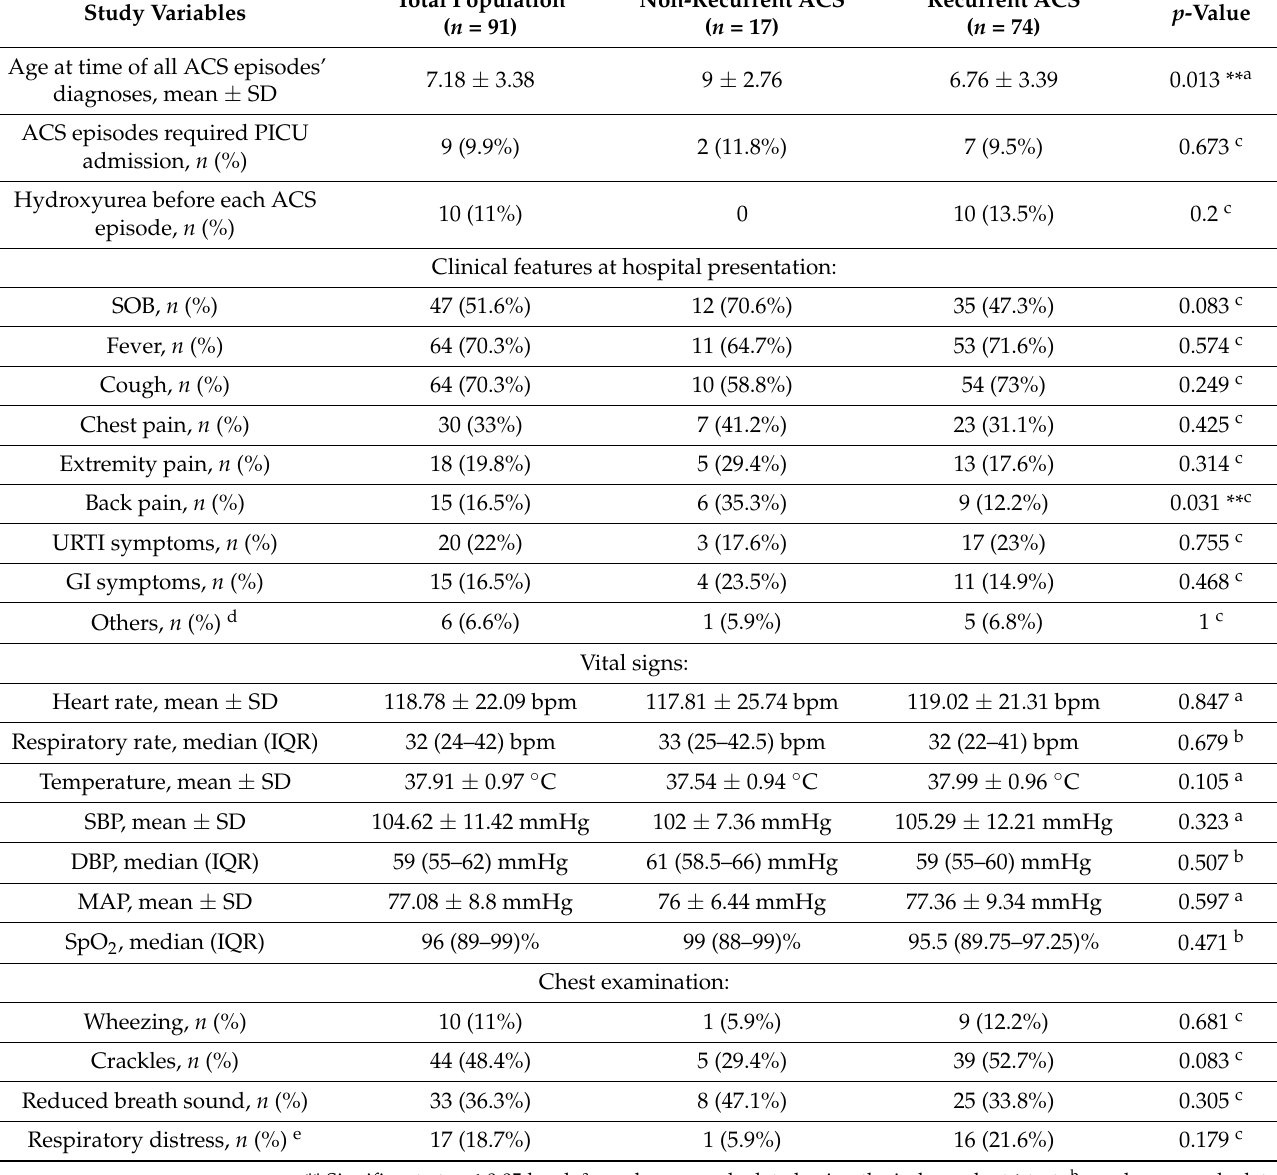
Table 2. ACS episodes’ characteristics, clinical features, and physical examination ( n =